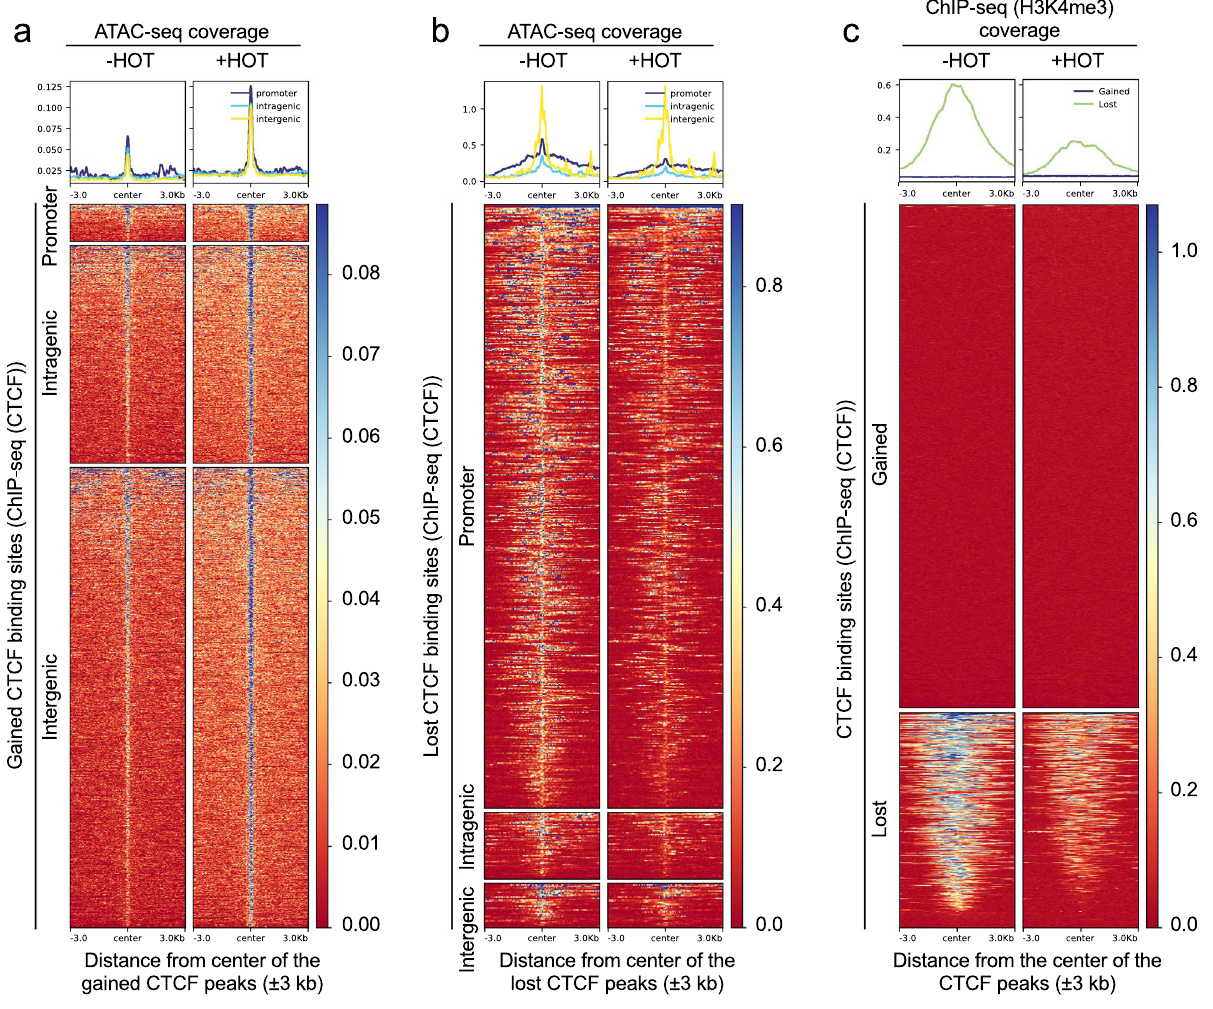
Figure 5. Loss of CTCF peaks at promoters is accompanied by a loss of H3K4me3 and an increased chromatin compaction. ( a ) Heatmaps showing the normalized ATAC-seq signals centered at gained CTCF binding sites (q < 0.05; logFC > 1) grouped to promoters (± 3000 bp of TSS), and intra- and intergenic regions. ( b ) Heatmaps showing the normalized ATAC-seq signals centered at lost CTCF bindings sites as in panel ( a ). ( c ) Heatmaps showing the normalized H3K4me3 signals centered at gained and lost CTCF binding sites (q < 0.05; log2FC > 1; ± 3000